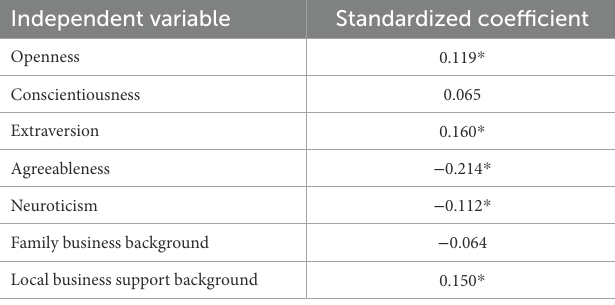
TABLE 4 The model of the big five factors of personality, sociological entrepreneurial background, and establishment of companies (multiple regression